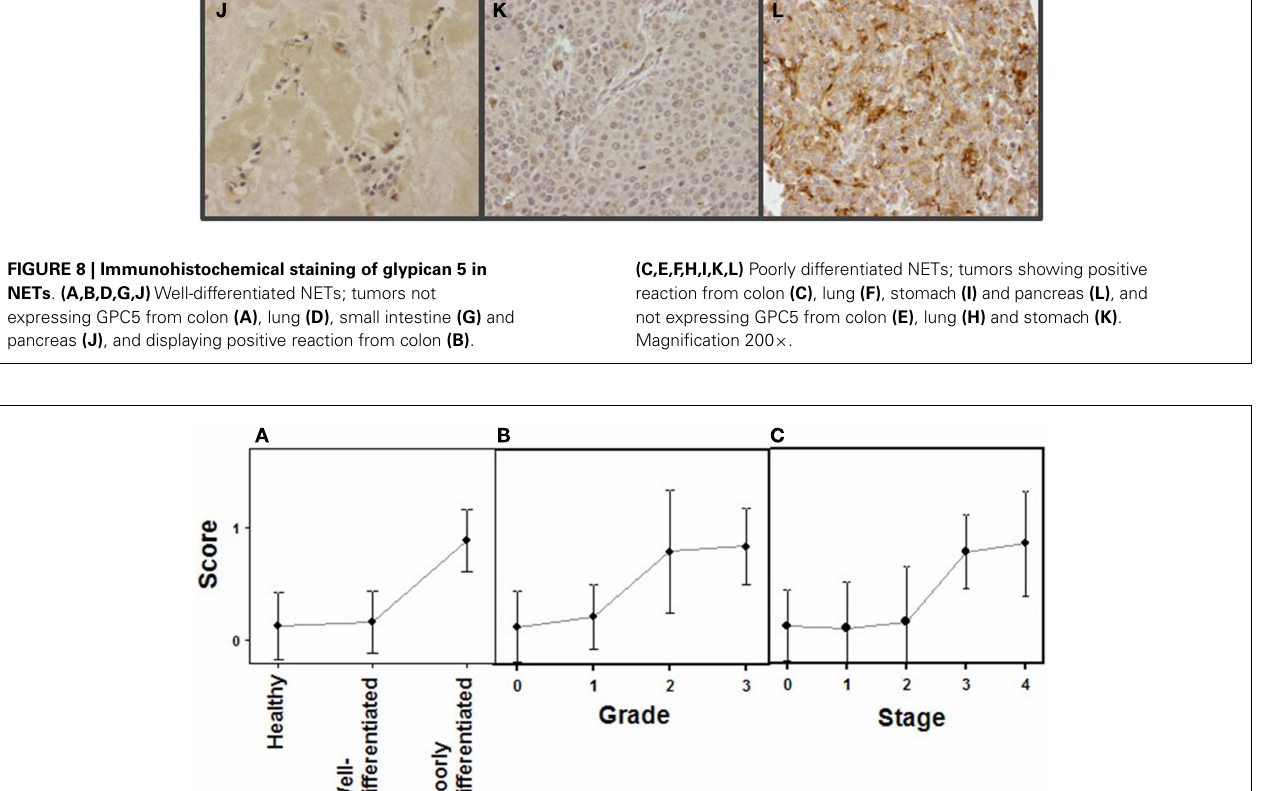
FIGURE 9 | Quantification of immunochemical staining of glypican 5 . (A) Relative to tumor differentiation. (B) Relative to tumor grade. (C) Relative to tumor stage. Semiquantitative scale from 0 to +++ was used.Vertical bars denote 0.95 confidence intervals.